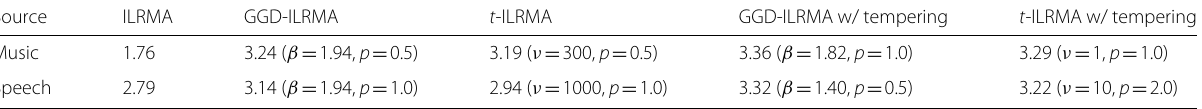
Table 9 Overall average SDR improvements (dB) in three-source case for the best parameter settings Source